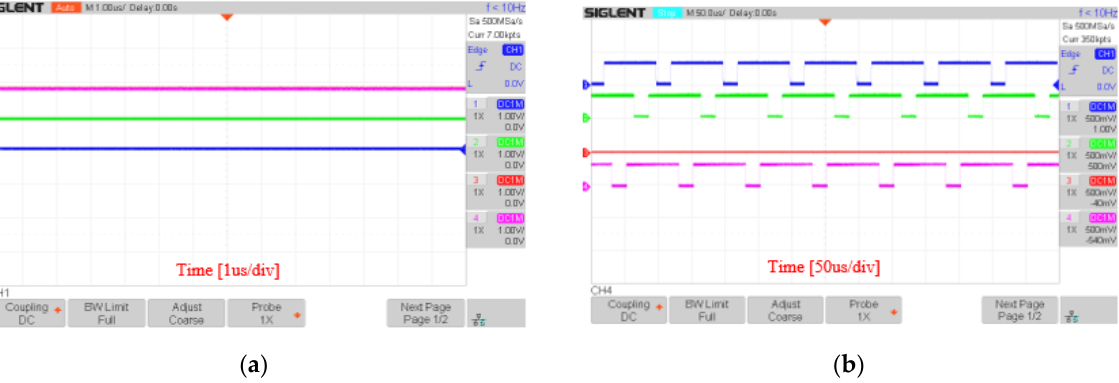
Figure 32. Experimental result of three interleaved carriers using DSA-PSC method, ( a ) carrier phases; ( b ) PWM control signals.